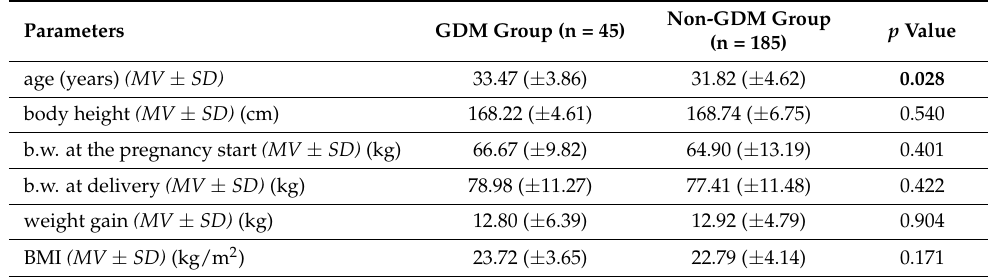
Table 1. Maternal parameter characteristics of the study